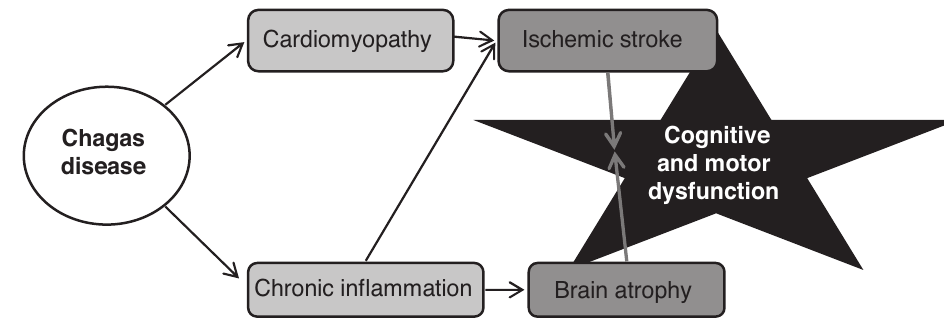
Figure 1. Proposed theory for brain dysfunction in Chagas disease. Chagas disease causes both structural heart damage and chronic activation of the immune system, mostly by Th1-type cytokines. Structural cardiomyopathy and chronic inflammation exert independent and synergistic effects on ischemic stroke risk, while chronic inflammation may induce brain atrophy. Finally, both multiple brain infarcts and brain atrophy impact brain dysfunction such as motor and cognitive